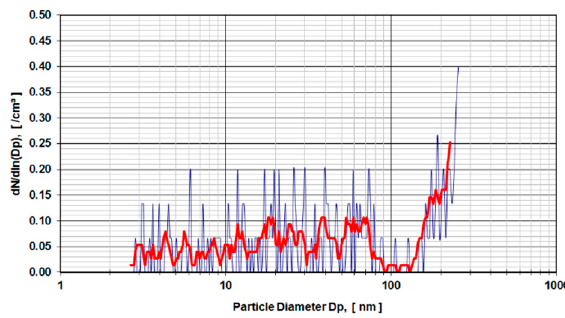
Figure 4. Metal-on-metal articulation in digested calf serum, dilution 1:3.